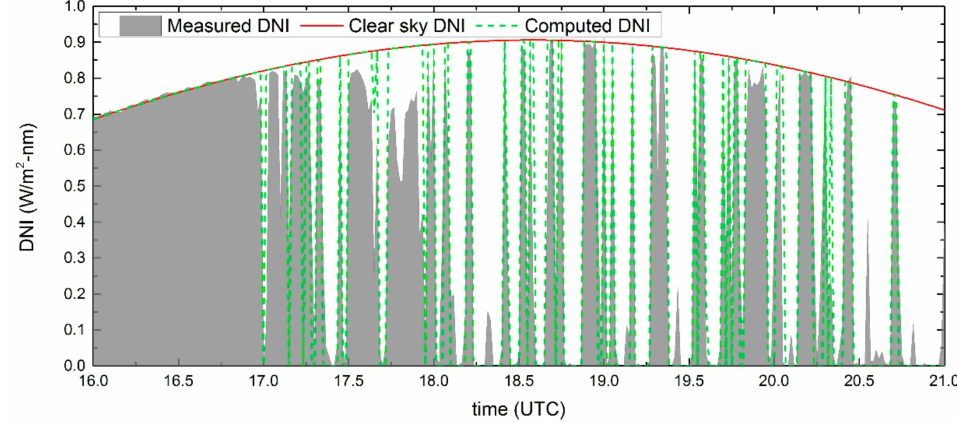
Figure 2. The simulation of direct solar irradiance on 7 July